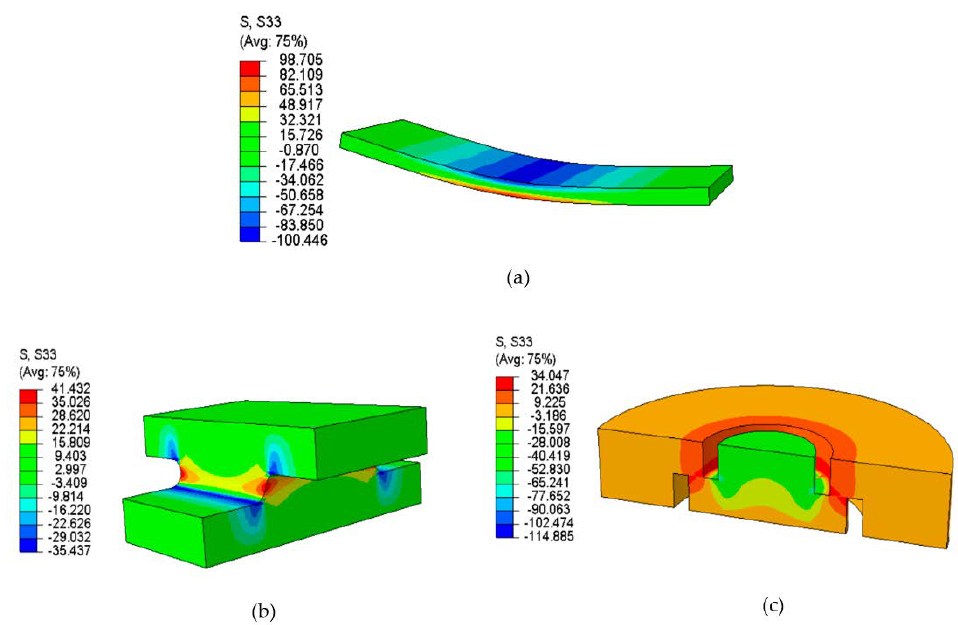
Figure 11. Stress contour plots for ( a ) three-point bend ( b ) cruciform and ( c ) punch-out